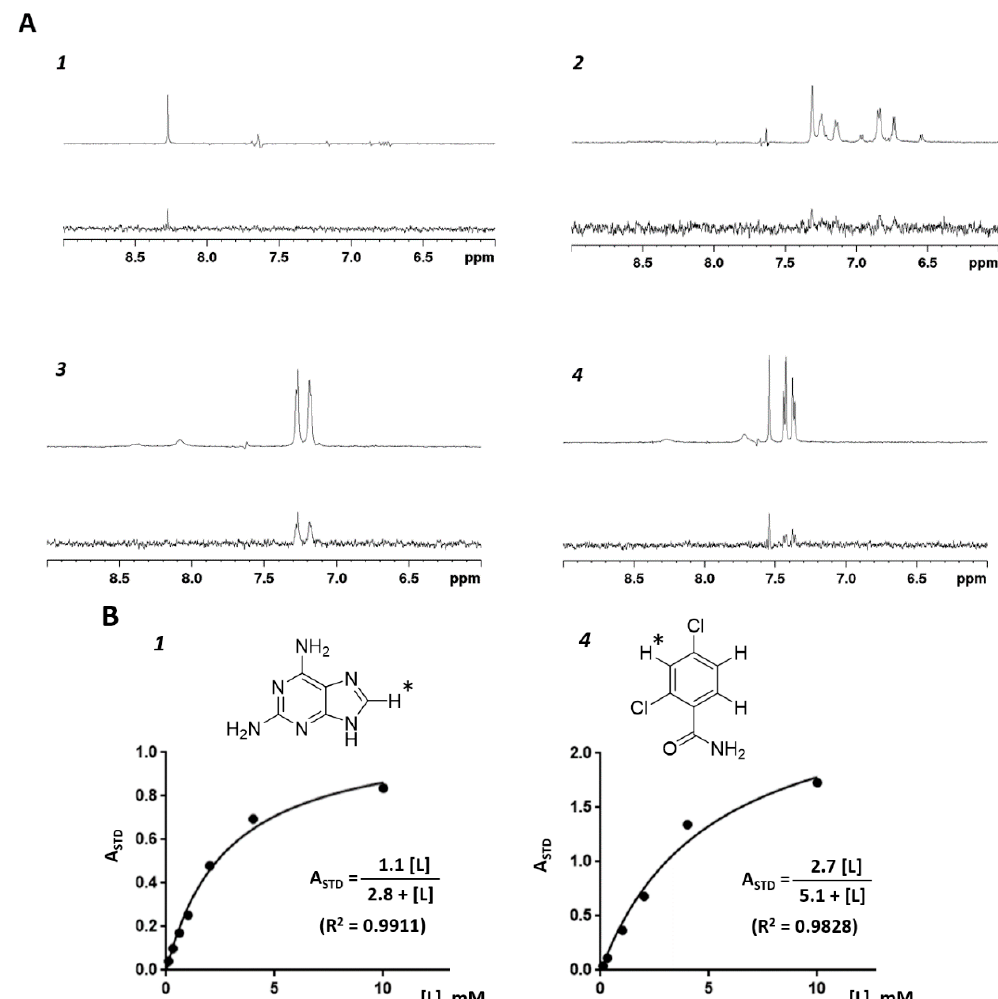
Figure A1. Saturation transfer difference (STD) studies. ( A ) Spectra illustrating the binding of four fragments at 1 mM concentration to ZIKV NS3-Hel. For each fragment, reference 1 H NMR spectrum is shown on top, and the STD spectrum is shown at the bottom. ( B ) STD amplification factors A STD plotted vs the ligand concentration for fragments 1 and 4 . The plots are based on singlet peaks which arise from the protons, indicated with a star on the structural diagrams (top).